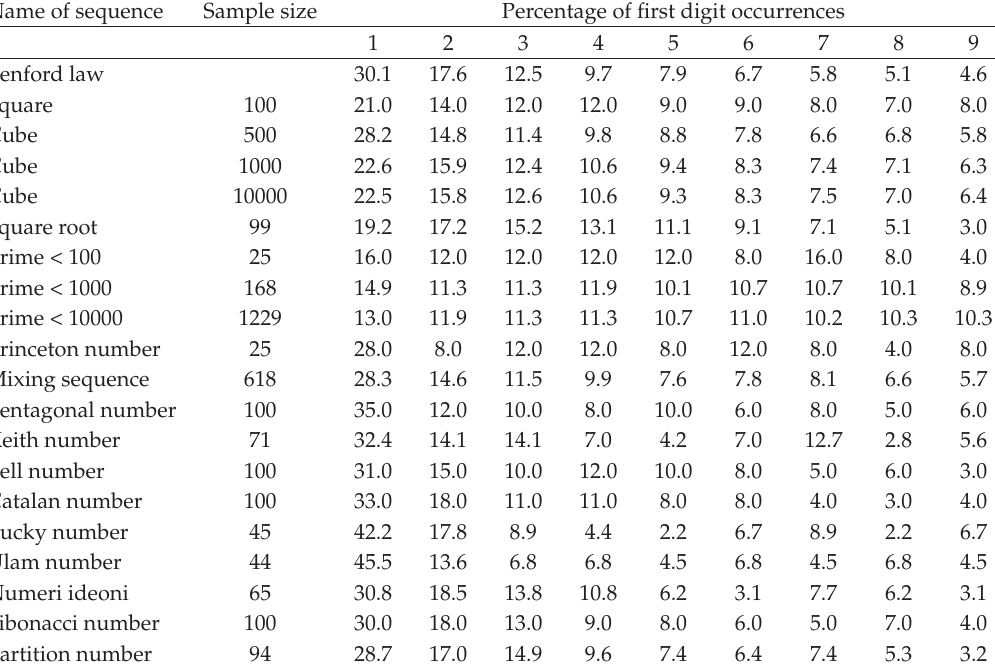
Table 1: First digit distributions of some integer sequences.